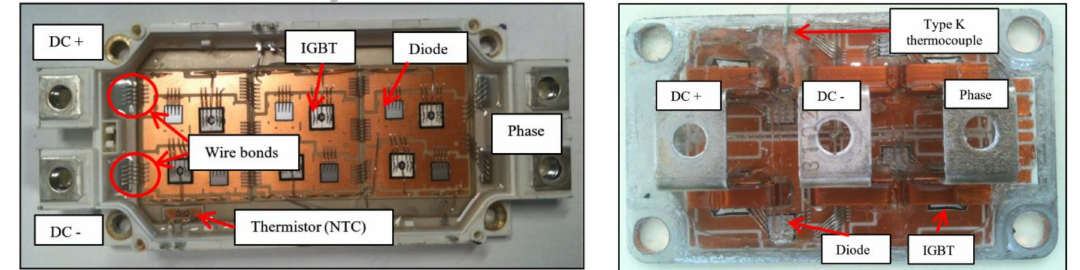
Figure 1. Top view of the power modules: ( a ) Module M; ( b ) Module K.